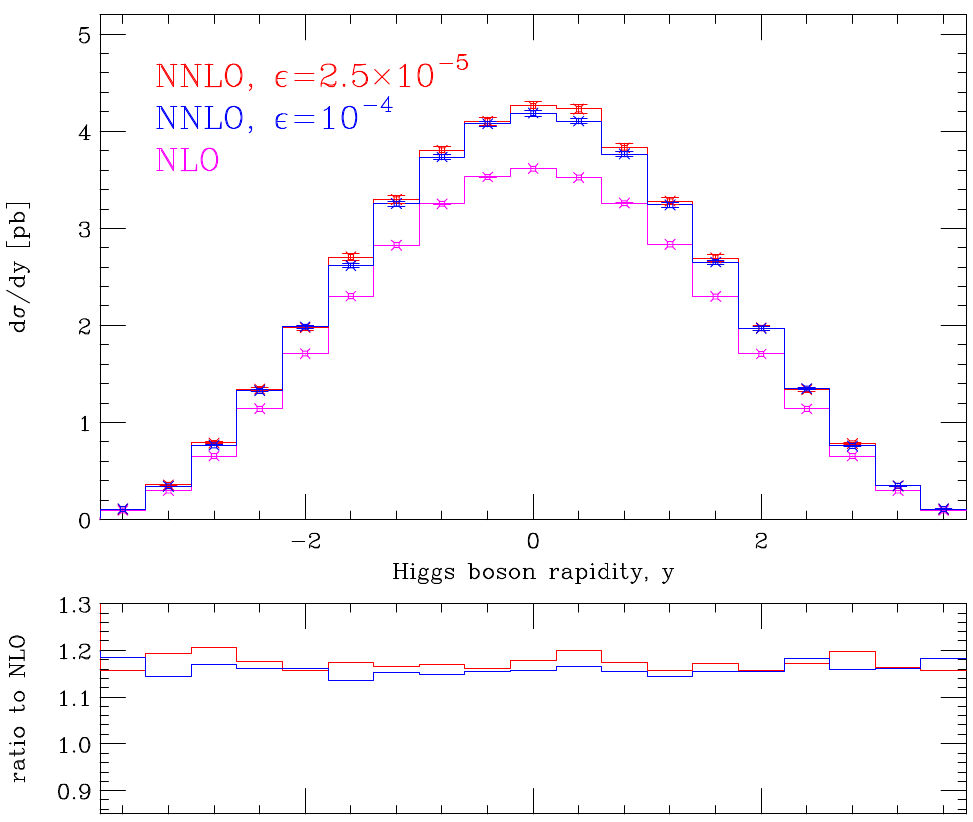
Figure 6 . The rapidity distribution of the Higgs boson computed at NLO and NNLO using MCFM, in the NNLOJET setup. The NNLO coe(cid:14)cient is calculated using both (cid:15) = 2 : 5 (cid:2) 10 (cid:0) 5 and (cid:15) = 10 (cid:0) 4 in the boosted de(cid:12)nition of T 1 . The lower panel shows the ratio of the NNLO and NLO